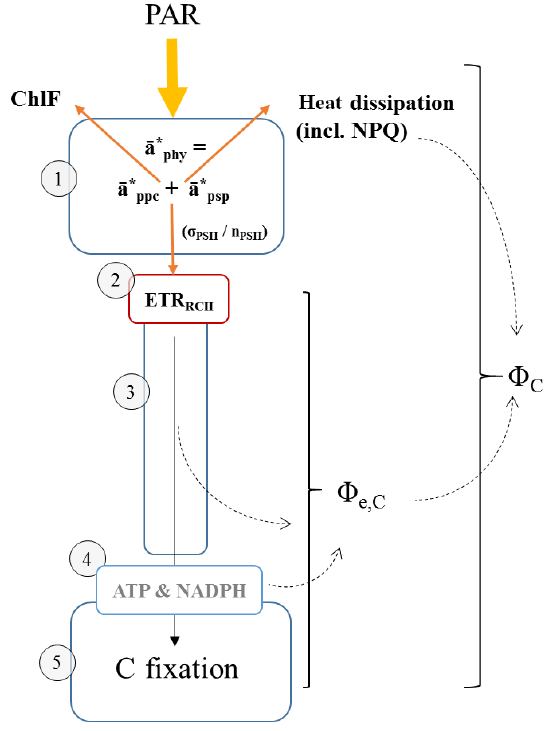
Figure 1. Schematic diagram of the photosynthetic process, high- lighting rates, variables and conversion factors measured or de- rived during this study. (1) Light absorption: photosynthetically available radiation (PAR, 400–700nm) is absorbed by phytoplank- ton ( a ∗ , m − 2 mgChl a − 1 ). Total absorption by phytoplank- phy ton can be subdivided into absorption by photosynthetic pigments ( a ∗ psp , m − 2 mgChl a − 1 ) and photoprotective carotenoids ( a ∗ ppc , m − 2 mgChl a − 1 ). The parameter a ∗ psp , if specific for PSII (pho- tosystem II) only, can be further decomposed into values of the functional absorption cross section of each RCII (reaction centre II) in the dark-regulated state, i.e. not affected by NPQ ( σ PSII , Å 2 RCII − 1 ) and the number of functional RCII per Chl a (n PSII , RCII Chl a − 1 ). Both σ PSII and n PSII can be adjusted to regulate the amount of excitation energy reaching RCII. The light energy absorbed by the pigments of PSII can have three fates: photochem- istry (ETR RCII ), dissipation as heat (including the upregulation of NPQ) and re-emission as fluorescence (ChlF). Changes in ChlF can be used to infer changes in the other two pathways. (2) Initial charge separation in RCII (ETR RCII , mole − molRCII − 1 s − 1 ). (3) Elec- tron transport after initial charge separation in RCII ultimately leads to the generation of “photosynthate” ((4) ATP and NADPH), which in turn can be used for carbon fixation ((5) C fixation, here mea- sured as 14 C uptake). The electron requirement of carbon fixation (cid:56) e , C (mole − molRCII − 1 ) is the ratio of electrons displaced by the initial charge separation in RCII to 14 C uptake. The photosynthetic efficiency, (cid:56) C (molCmolquanta − 1 ), is the amount of 14 C fixed per quanta absorbed. Under conditions when the rate of light absorption and delivery to RCII surpasses the potential for carbon fixation or reductant formation, both (cid:56) e , C and NPQ will increase to prevent over-reduction of RCII. The magnitude of (cid:56) C , in turn, is dependent on how much initially absorbed energy is dissipated as fluorescence (ChlF) and heat (including NPQ) as well as through processes de- coupling ETR RCII from 14 C uptake (reflected in (cid:56) e , C